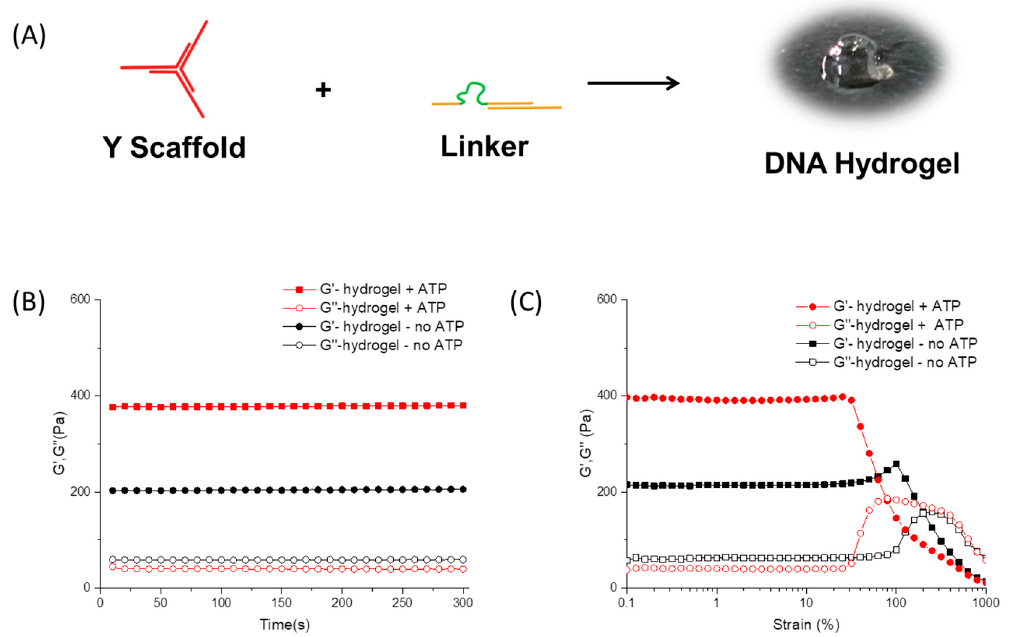
Figure 2. Fabrication and characterization of DNA hydrogel. ( A ) Formation of hydrogel by mixing the Y-scaffold (500 μ M) and B-linker (750 μ M) in 20 mM Tris-HCl buffer; ( B ) The mechanical strength Y-scaffold (500 µ M) and B-linker (750 µ M) in 20 mM Tris-HCl buffer; ( B ) The mechanical strength of the hydrogels with or without ATP was characterized by a time sweep test with a fixed strain of 1% and frequency of 1 Hz at 25 °C; and ( C ) The shear-thinning property of the hydrogels with or without ATP was measured by a strain sweep test from 0.1% to 1000% with a fixed frequency of 1 Hz at 25 °C.